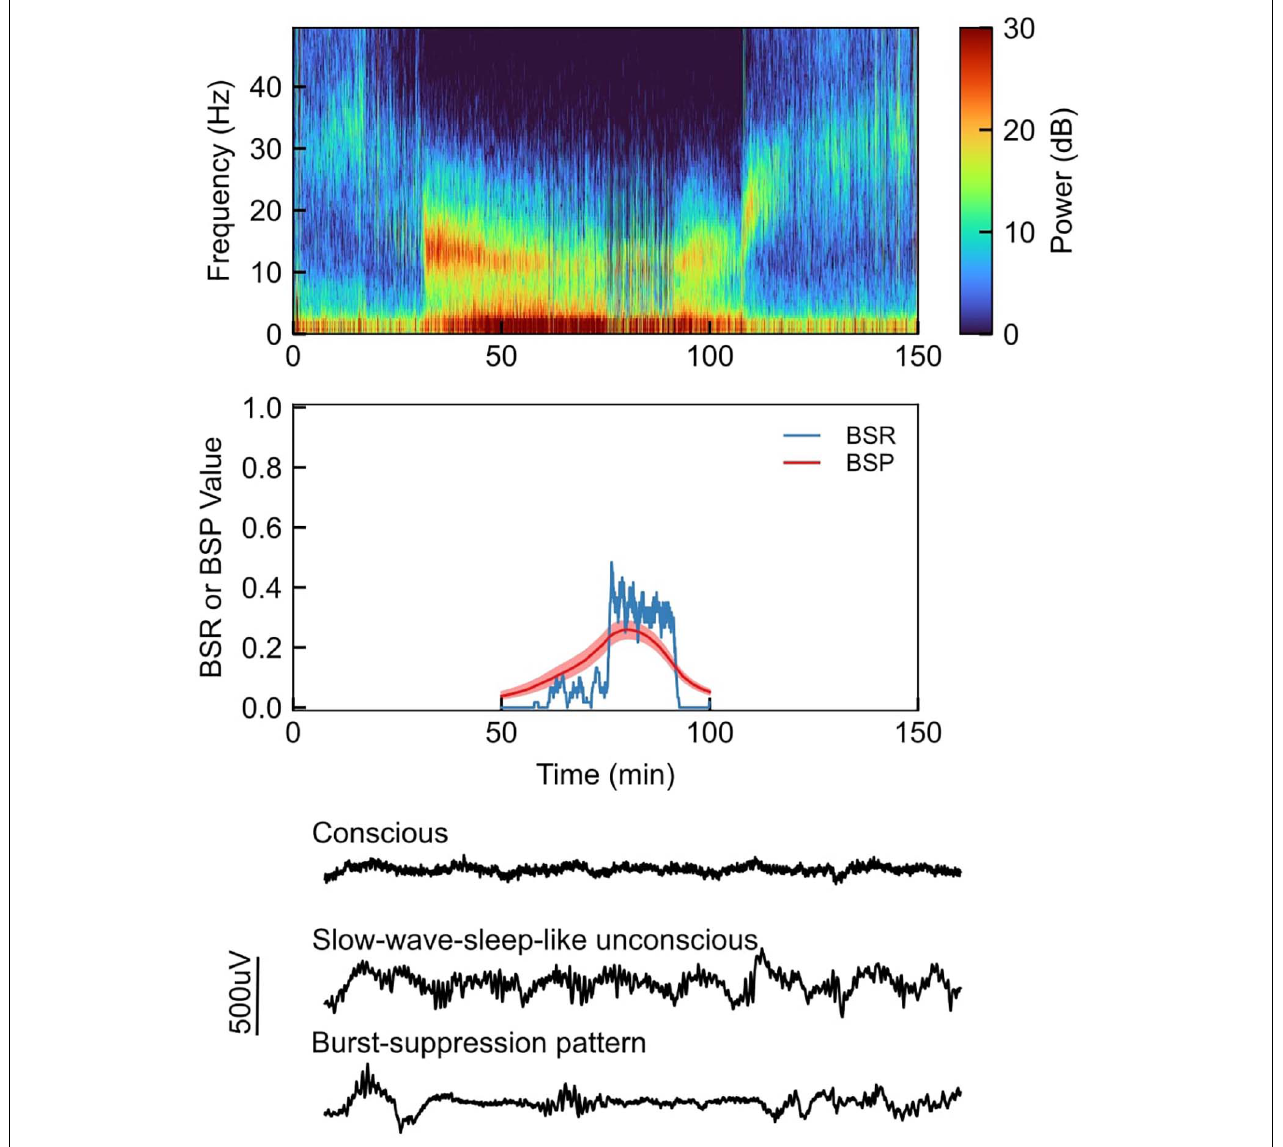
FIGURE 1 | Top: Sample EEG recording spectrogram from a healthy volunteer under propofol-induced anesthesia, with propofol being increased in a stepwise fashion; Middle: Quantitative visualization of BSR (burst suppression ratio) and BSP (burst suppression probability) during sample case; Bottom: Selected segments of the unprocessed EEG waveforms during sample